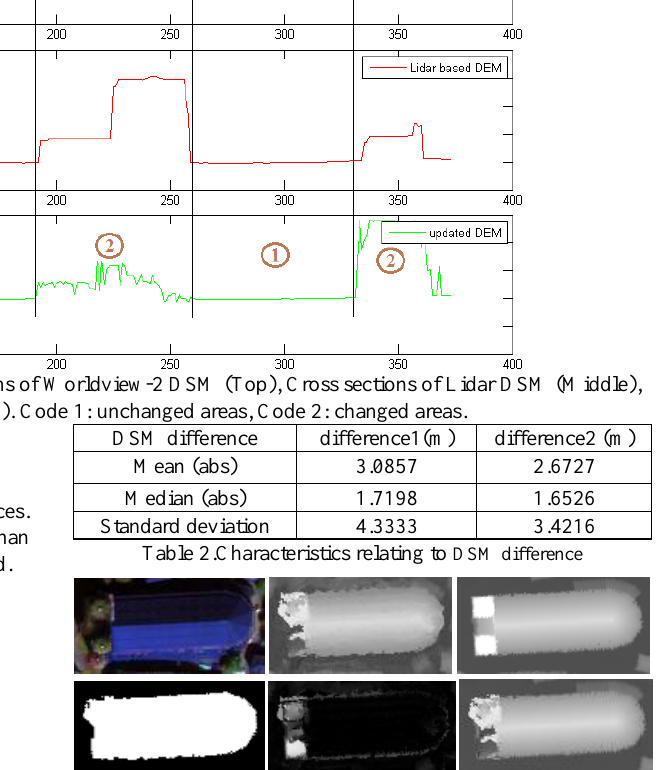
Figure 10.Top: Lidar DSM (right), Worldview2 DSM (middle), RGB image (left), Bottom: updated DSM (right), the absolute difference between two DSMs (middle), the sum of two DSMs